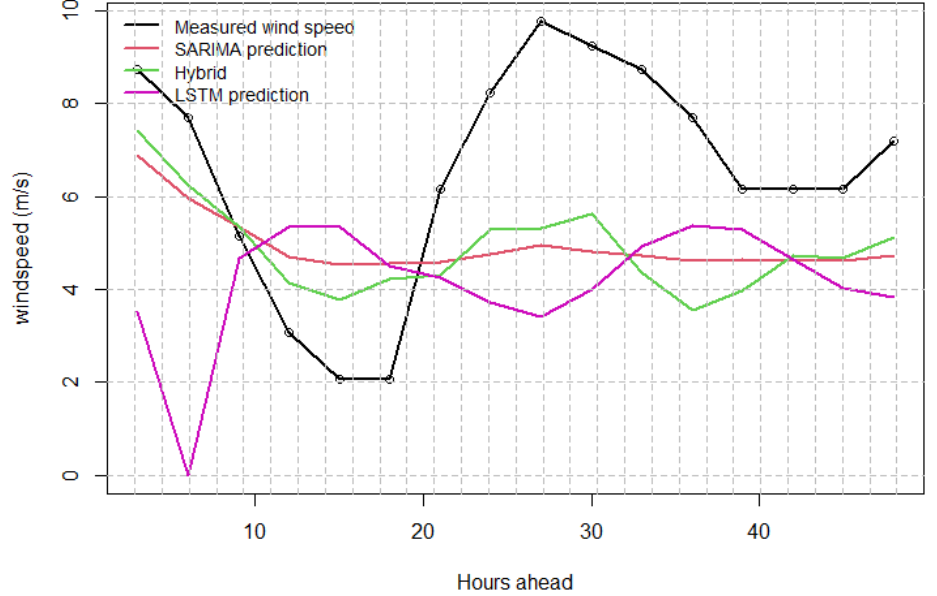
Figure 13. Comparison of SARIMA, LSTM and hybrid with real data for 2-day prediction horizon during May; wind speed example; high wind speed during previous